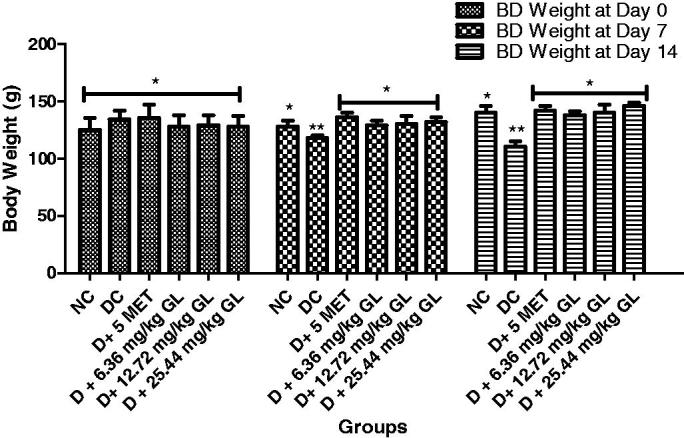
Aqueous leaf extract of G. latifolium on body weight of alloxan-induced diabetic rats. Values are expressed as mean ± standard deviation (SD) of eight replicates. Bar with the same * are not significantly different at p > 0.05. Bar with different * are significantly different at p < 0.05. NC: non-diabetic control; DC: diabetic control; D: diabetic; MET: metformin; GL: Gongronema latifolium leaf; BD: body weight.